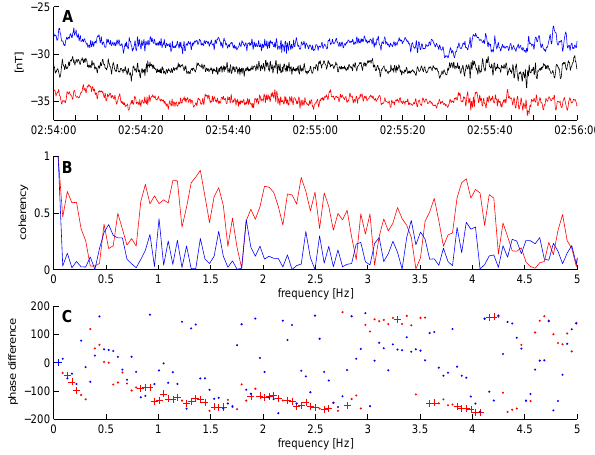
Fig. 6. Cross spectral analysis of the sunward-pointing perpendicu- lar magnetic field component for the spacecraft pairs C1-C2 which were situated almost along the same field line, and C1-C4 which had a larger perpendicular separation but a closer parallel separation. (a) Time series of the magnetic field. Black, red and blue are C1, C2 and C4, respectively. C2 and C4 have been shifted by –3nT and +3nT, respectively, for clarity. (b) Coherency from cross-spectral analysis. Red from the pair C1-C2, and blue from C1-C4. (c) Phase difference between the signals. The different markers corresponds to points with γ 2 ≥ 0 . 5 (crosses) or γ 2 < 0 . 5 (dots). Colors as in panel